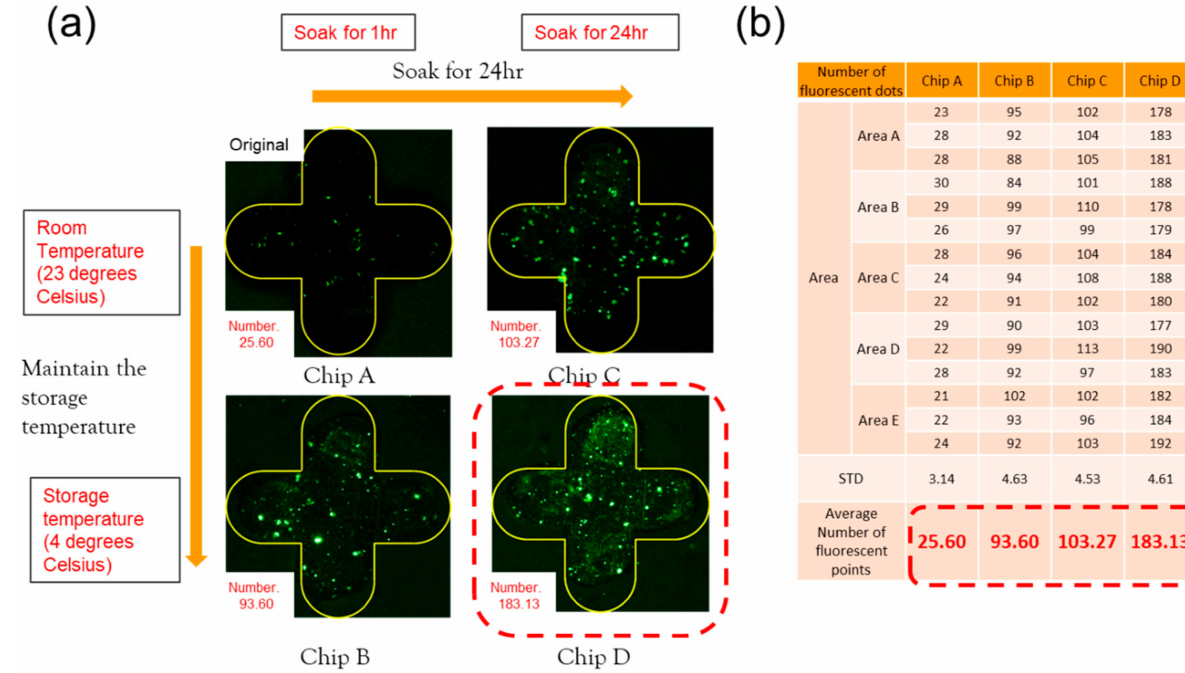
Figure 5. ( a ) Fluorescent dot picture; ( b ) number statistics of antibody parameter optimization